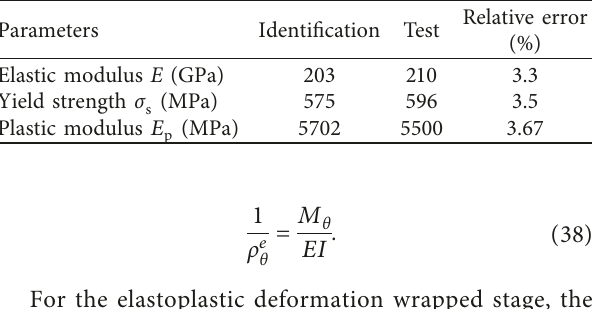
Table 2: Comparison with identification and